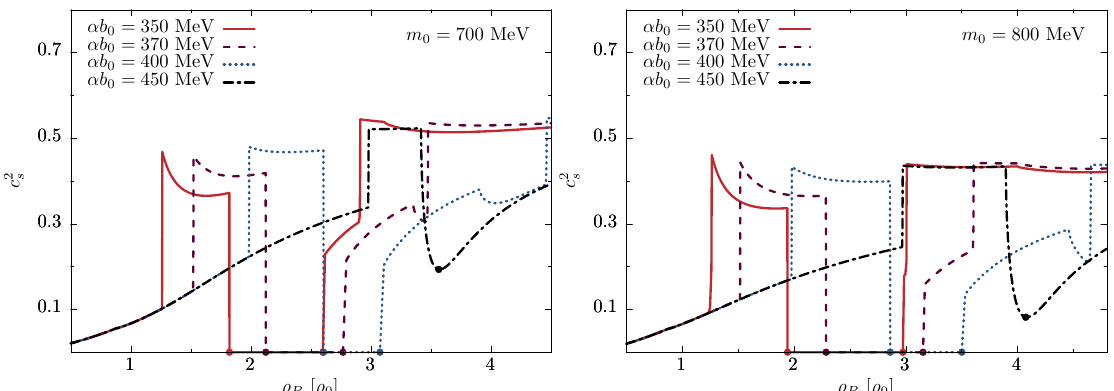
Figure 2. Speed of sound squared as a function of the energy density for m 0 = 700 MeV ( left ) and m 0 = 800 MeV ( right ). The regions between circles correspond to the coexistence of chirally broken and restored phases in the first-order phase transition. For α b 0 = 450 MeV, the transition is a crossover. The deconfinement transitions are triggered at higher densities and are not shown